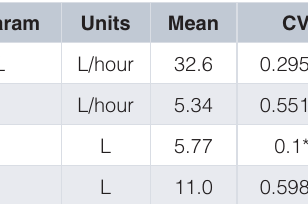
Table 1. Two-compartment pharmacokinetics of docetaxel, from Onoue et al. (2016) [9, Table 2]. CL : clearance; Q :